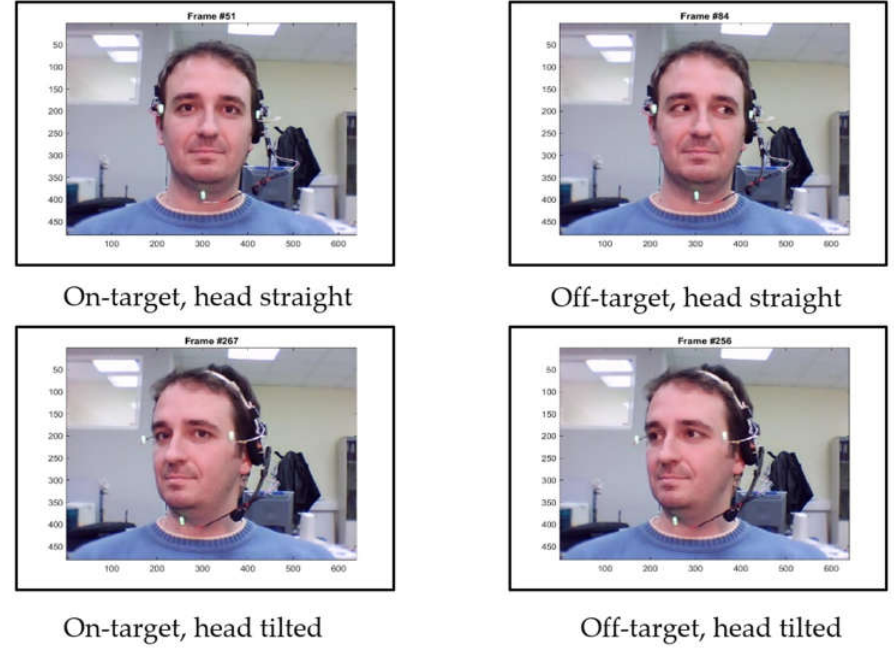
Figure 13. Example gaze labeling in videos of the public dataset from [24].